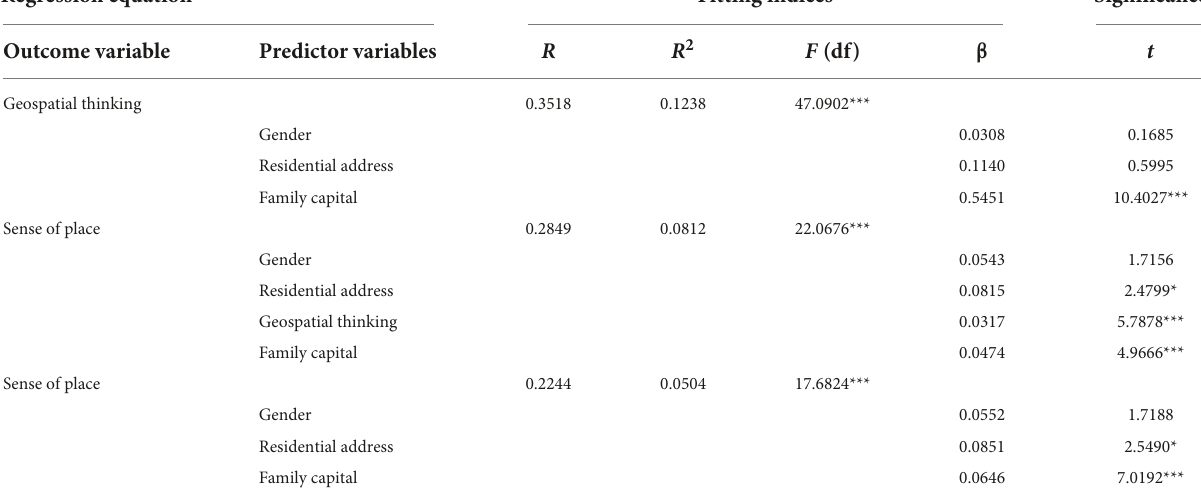
TABLE 3 Results of mediation analysis for the observed variables.